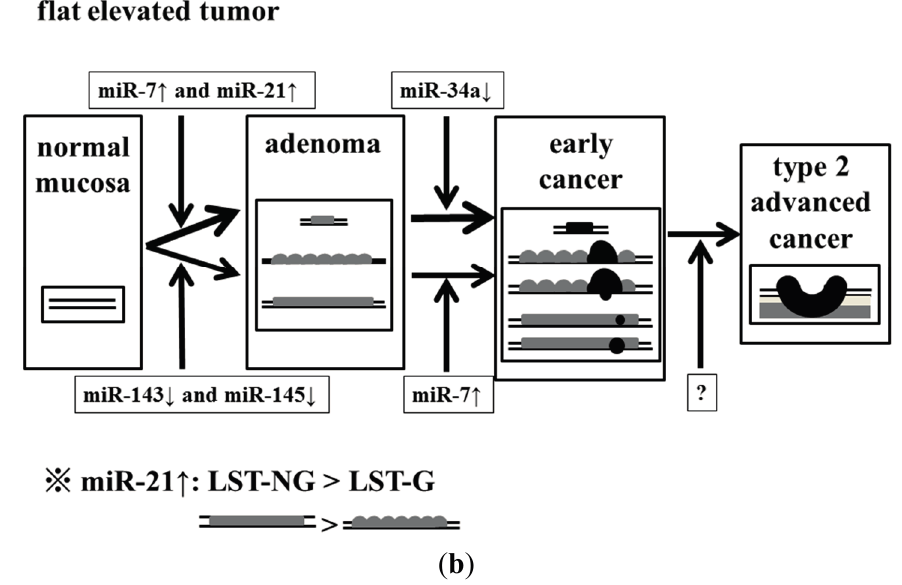
Figure 5. Effect of accumulation of aberrant miRNA expression on the process of malignant transformation in exophytic and flat elevated tumors. ( a ) Exophytic tumor; and ( b ) Flat elevated